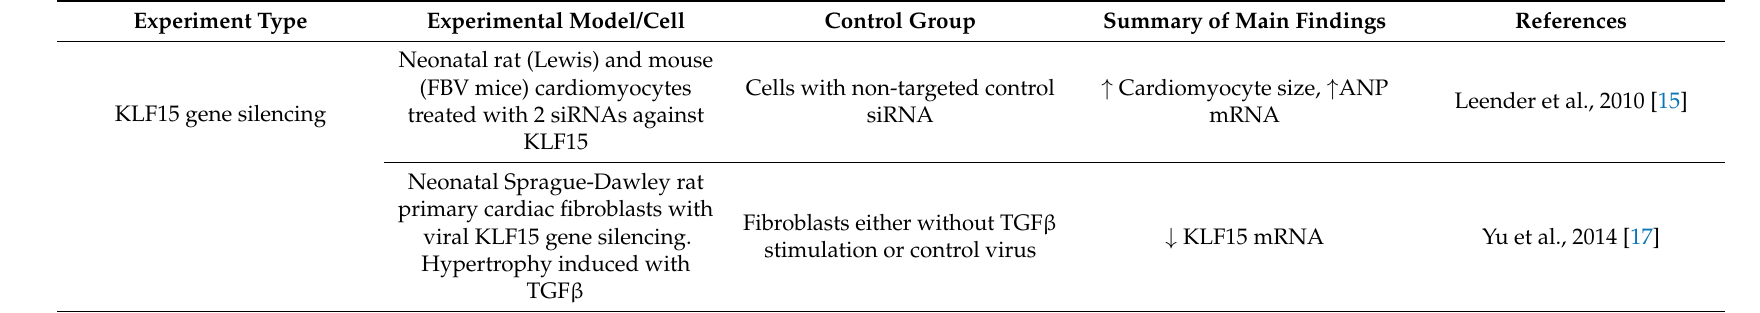
Table 2. In vitro KLF15